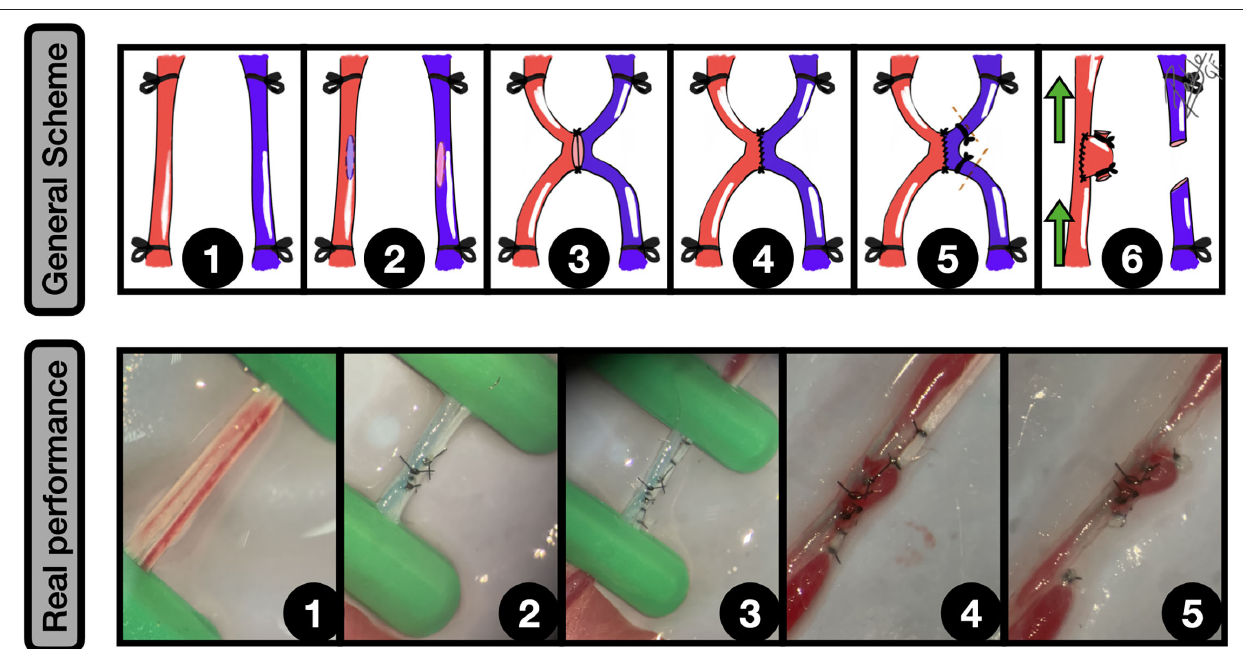
FIGURE 5 | Side-to-side arteriovenous fistula (AVF). General scheme: 1: Femoral artery and vein are widely exposed and proximal and distal clamped; 2: Lateral wall longitudinal arteriotomies of both vessels are performed; 3: The two first anchoring knots are made, bringing both vessels together; 4: Side-to-side anastomosis between artery and vein is completed; 5: A double ligature of the vein, near to the anastomotic zone is made, and a subsequent section is performed to create the dome of the aneurysm from this vessel; 6: After clamping releasing an inflow can be observed into the aneurysm. The green arrows indicate the blood flow direction. Real performance: 1: Femoral artery and vein exposure and clamping; 2: Side-to-side anastomosis; 3: Distal and proximal femoral vein ligatures, to ensure a proper segment length for the aneurysm; 4: The clamps are released and the isolated venous segment receives an inflow from the femoral artery, which remains between the ligature limits; 5: The distal and proximal ligated segments of the femoral vein are sectioned, obtaining a sidewall aneurysm that arises from the femoral artery. Mild vasospasm can be